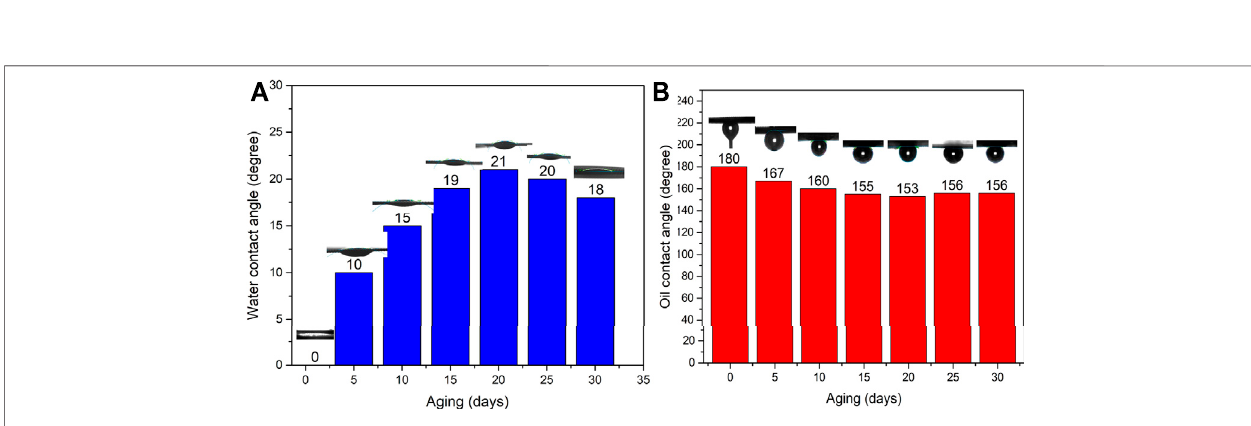
Frontiers in Chemistry |